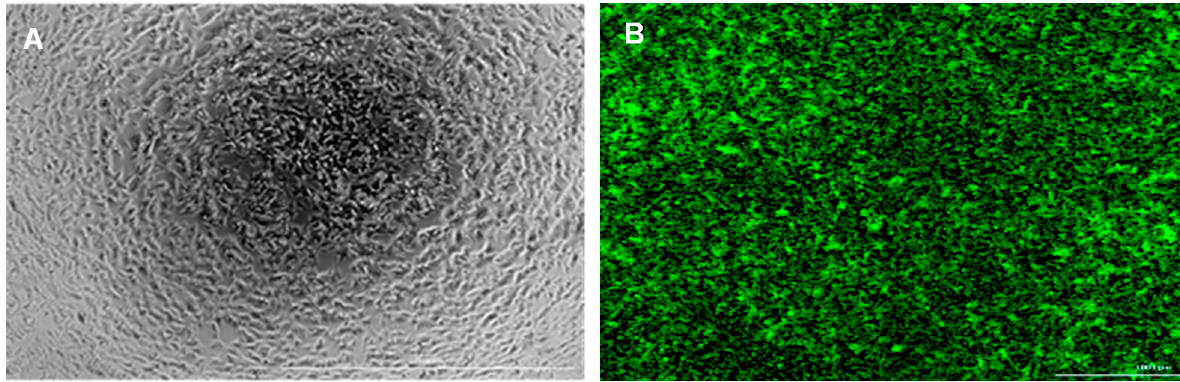
Figure 2. Phase-contrast images of untreated human SH-SY5Y cells ( A ) for 24 h and fluorescence images of untreated SH-SY5Y cells ( B ). Scale bar: 1020 µm.